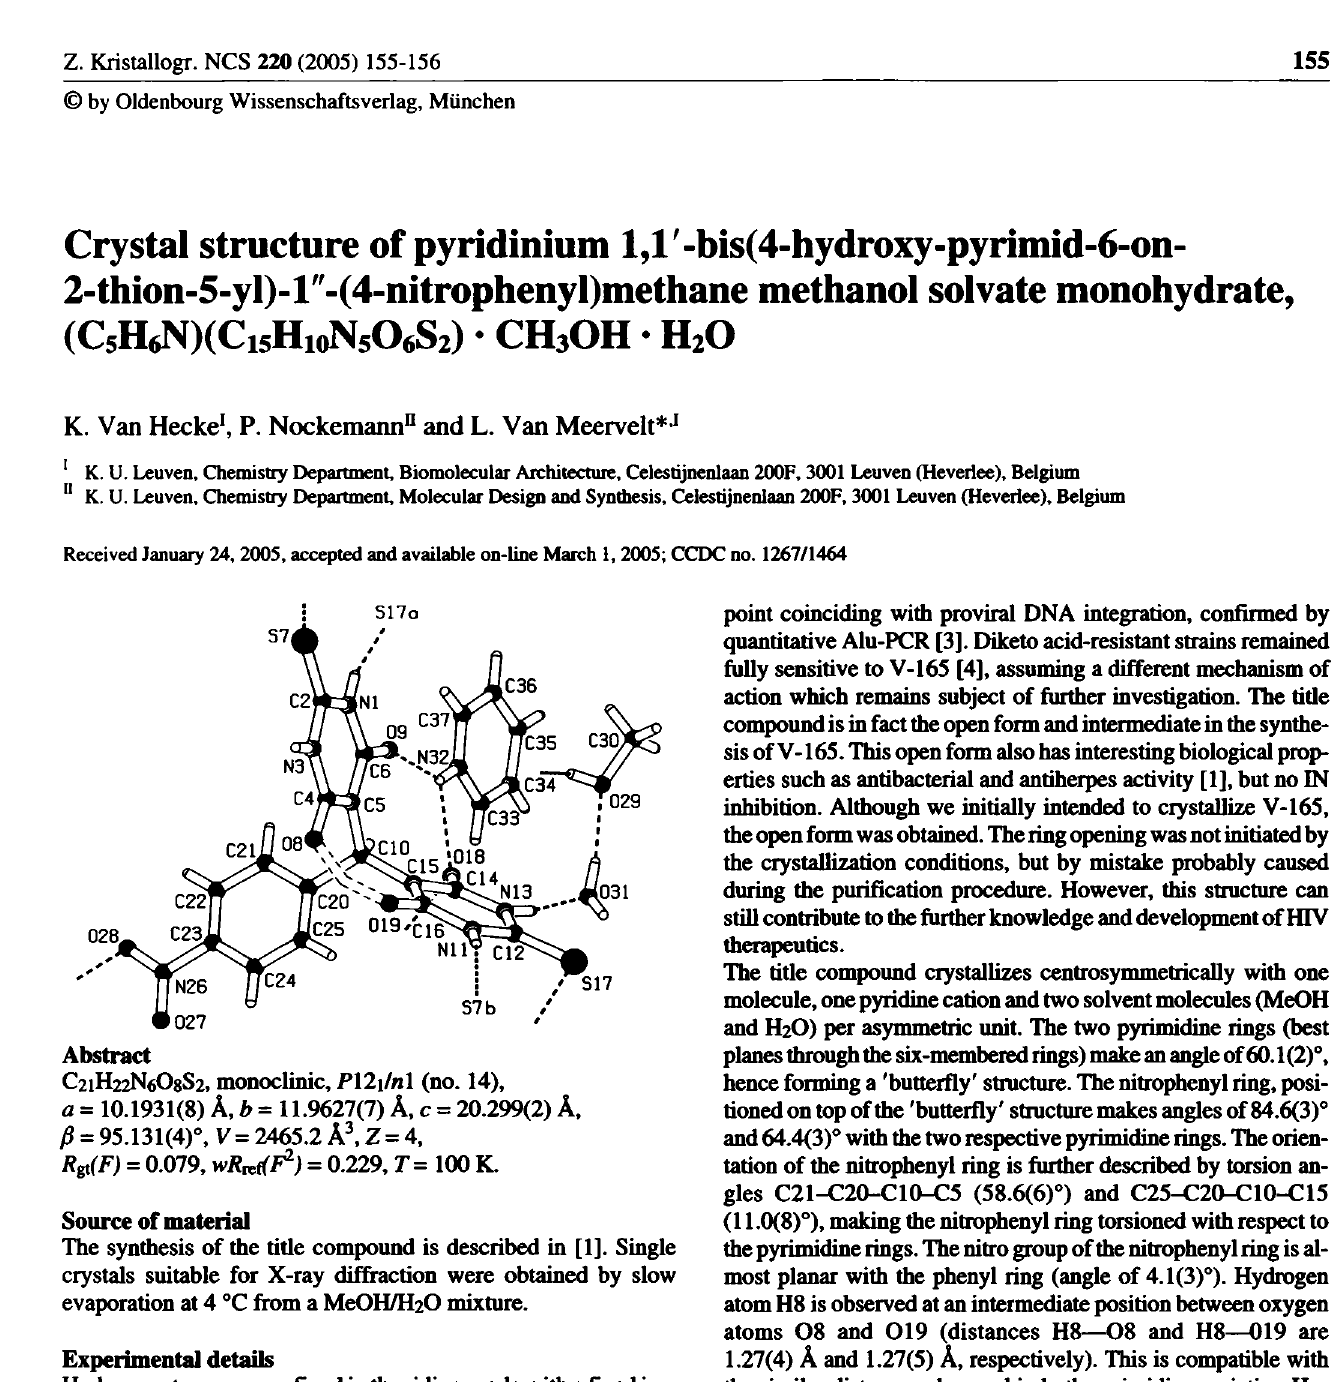
Table 1. Data collection and handling. Crystal: